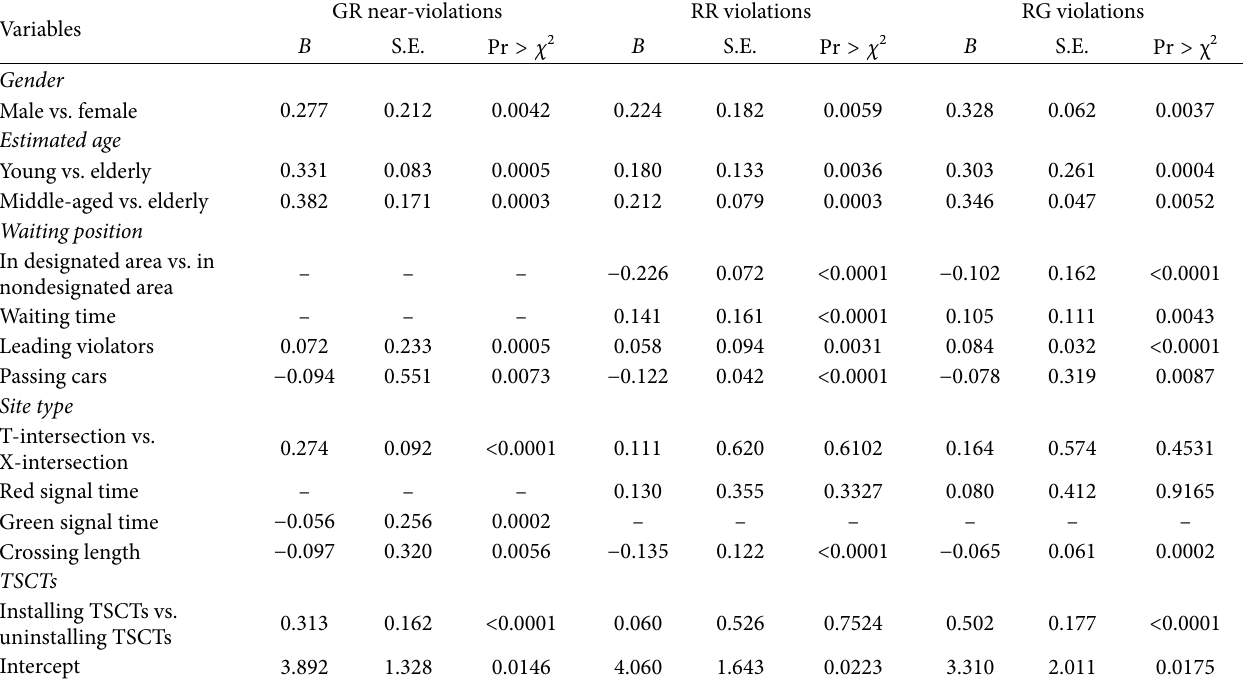
Table 8: Results of the final logistic regression models for three violation types.